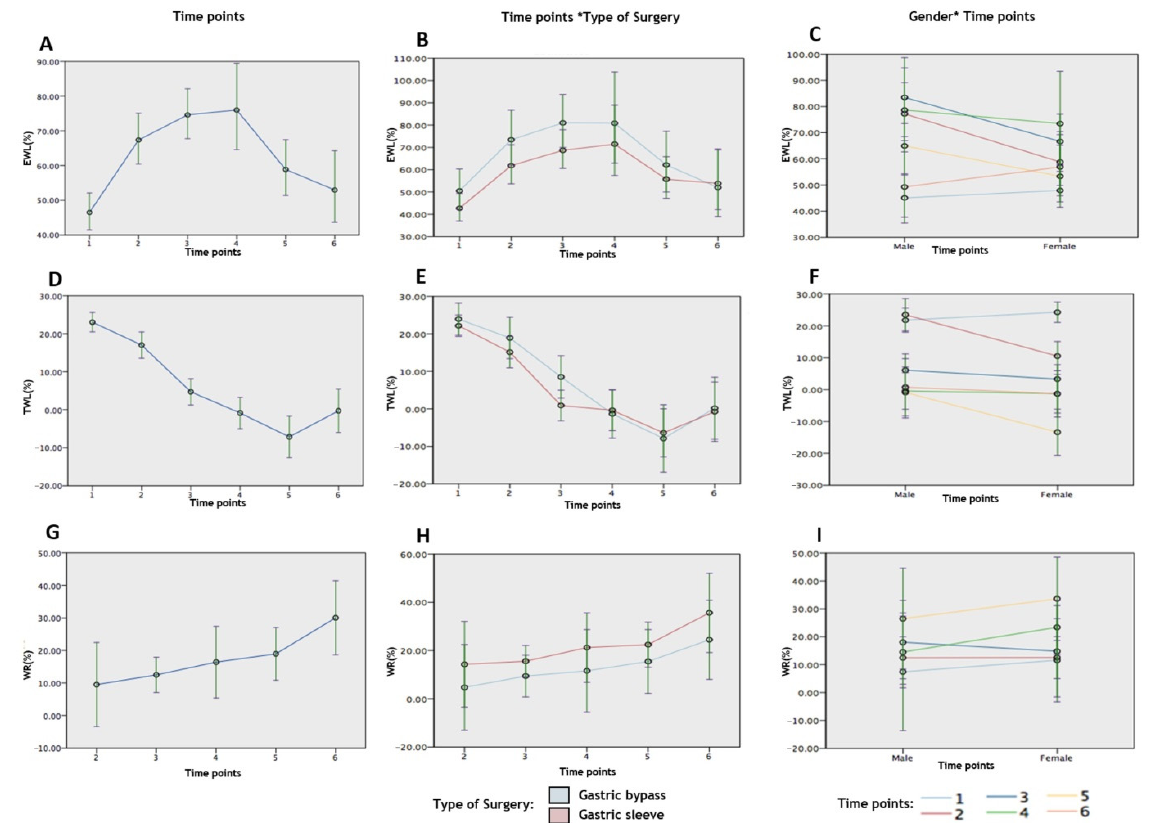
Figure 3. The figure shows a line graph with 95% confidence intervals and depicts the changes in the estimated mean of outcome variables with the predictors over the study duration at the different time points. The changes in %EWL with ( A ) different time points, ( B ) time points and type of surgery, and ( C ) time points and gender; the changes in %TWL with ( D ) different time points, ( E ) time points and type of surgery, and ( F ) time points and gender; and the changes in %WR with ( G ) different time points, ( H ) time points and type of surgery, and ( I ) time points and gender are shown. Table 2. Comparison of repeated measure (%EWL, %TWL, and %WR) mean (SD) values of study subjects across the six time points and the difference between each time point and at the end observation time point. Time Points (in Years) F-Value p -Value Outcome Variables